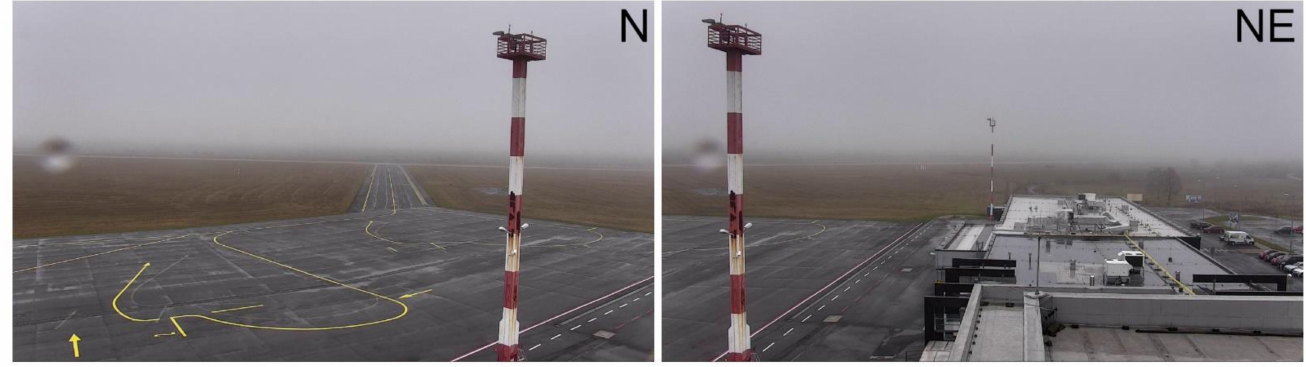
Figure 16. The same as Figure 15, but for 28 October 2018, at 06:50 UTC. Table 12. The same as Table 11, but for 28 October 2018, at 06:50 UTC. BR—mist, FG—fog. AWOS RO LO Visibility [m] 3000 700 700 Phenomenon BR FG